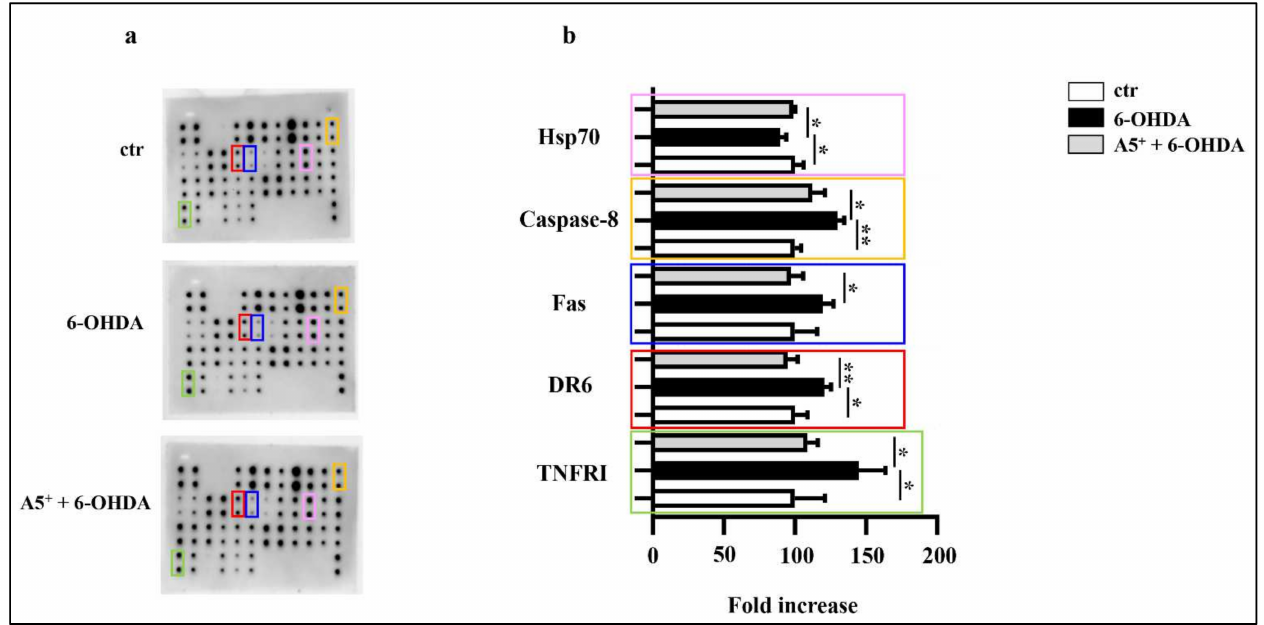
Figure 5. A5 + blunted the death-receptor-induced apoptotis. ( a ) Representative blot assay reporting all factors evaluated; ( b ) Bar graph illustrating the most relevant factors modulated by both 6-OHDA and A5 + administration. Data are reported as mean ± SEM ( n = 4). (* p < 0.05; ** p < 0.005). ctr: control; 6-OHDA: 6-hydroxydopamine; TNFRI: Tumor Necrosis Factor Receptor I; DR6: Death Receptor 6; Hsp70: Heat Shock Protein